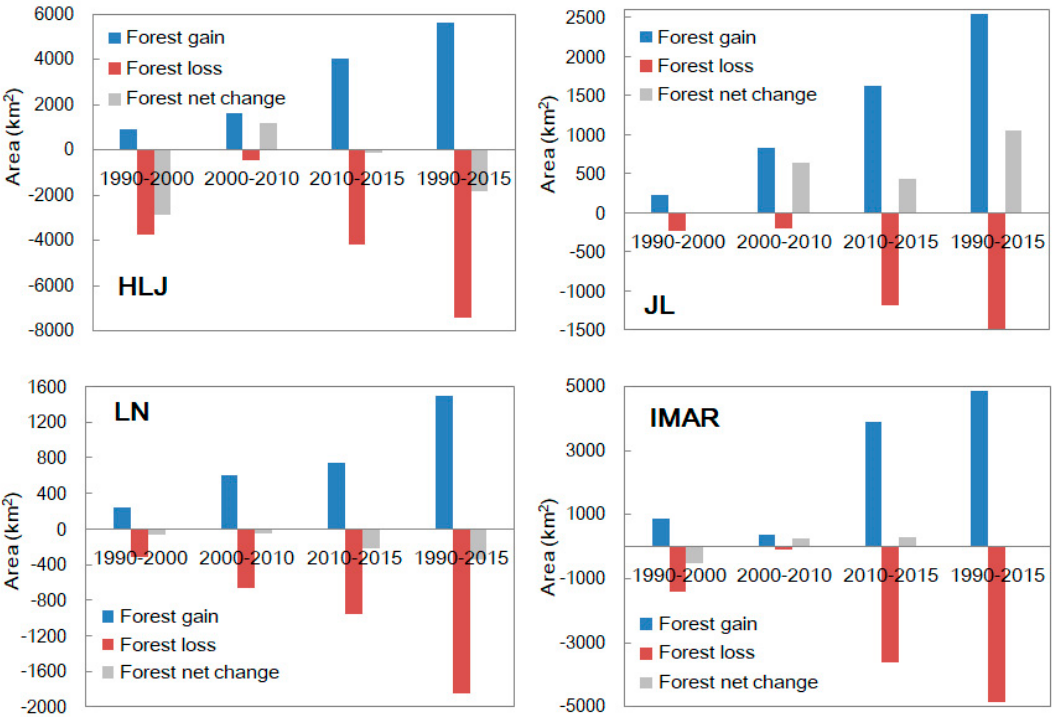
Figure 7. The area changes of forests in provinces of northeast China during 1990–2015.